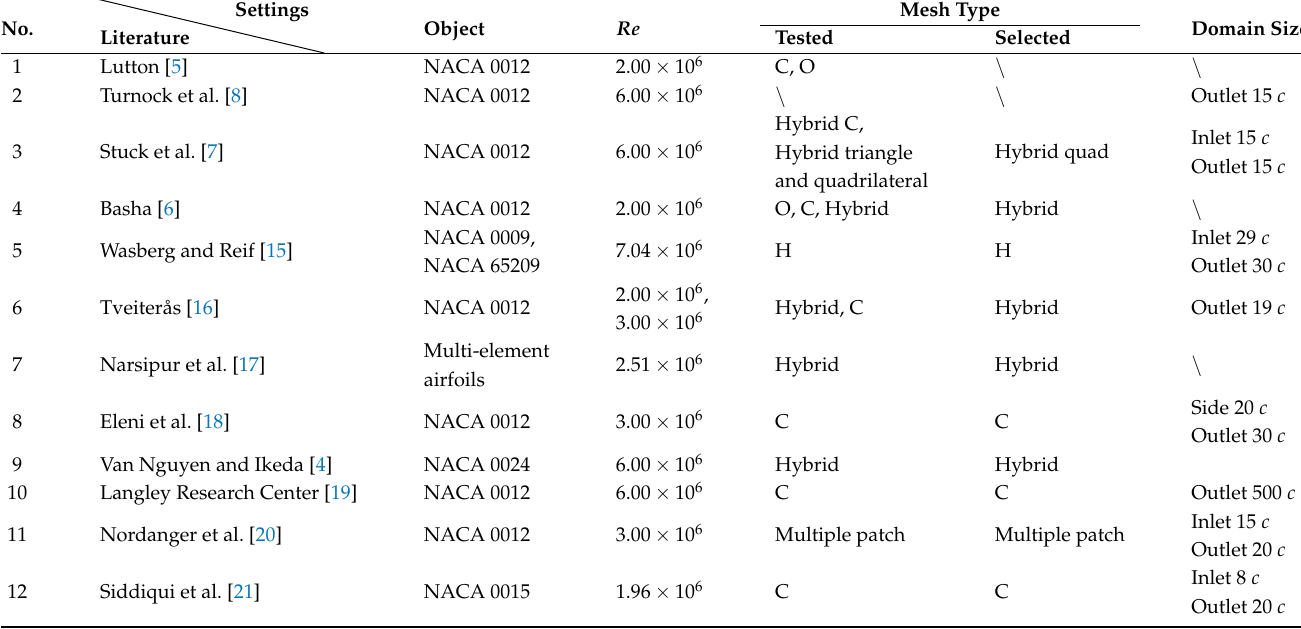
Table 1. Mesh properties studies in literature: objects, Reynolds numbers, mesh types, and domain sizes.